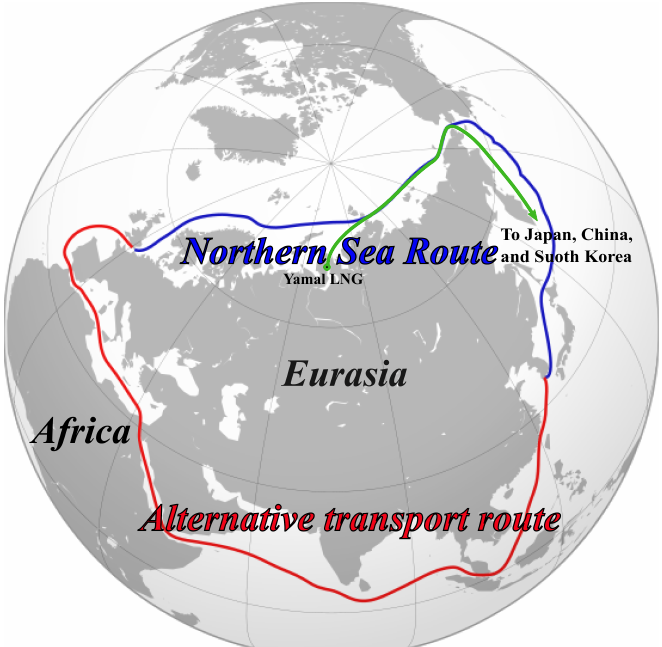
Figure 1. A map showing the transportation of goods by sea between East Asia and Europe along the Northern Sea Route (blue line) the Suez Canal (red line). In 2021, a Yamalmax-class LNG tanker made its first independent voyage (without icebreaker escort) with cargo from the port of Sabetta along the Northern Sea Route to the east (green